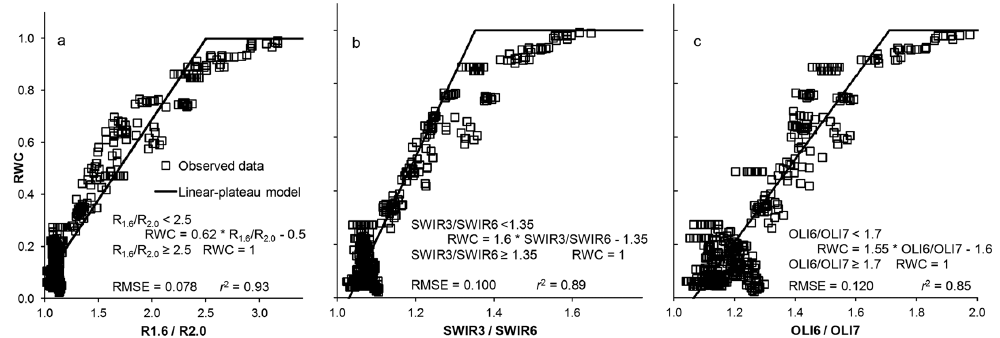
Figure 10. RWC for mixture scenes of crop residues and soils in the field measurements as a function of water indices based on reflectance ratios for: ( a ) narrow bands (R1.6/R2.0); ( b ) WorldView-3 bands (SWIR3/SWIR6); and ( c ) Landsat bands (OLI6/OLI7). Predicting field f R using the NDTI multivariate linear model had a large RMSE (>0.30) because of the difficulty of correcting the NDTI when the RWC was between 0.5 and 0.7 (Table 8). When scene RWC was estimated using the OLI6/OLI7 index, the RMSE was 0.34. Thus, the reliability of NDTI to predict crop residue cover is limited when variations in scene moisture conditions are likely. However, when field conditions are relatively dry (RWC < 0.25), the RMSE was 0.19 for NDTI